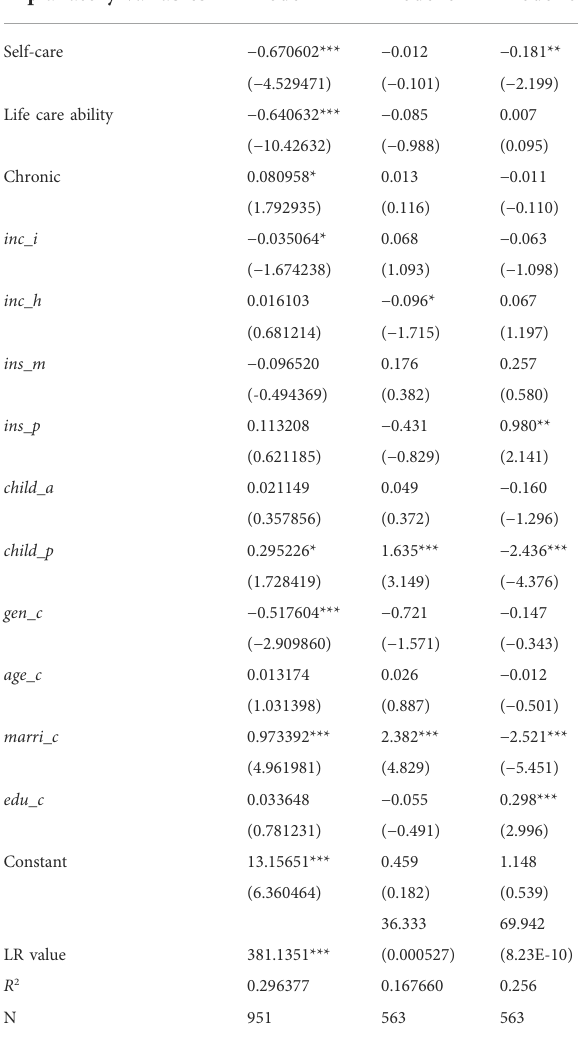
TABLE 5 Regression results of elderly care service supply in